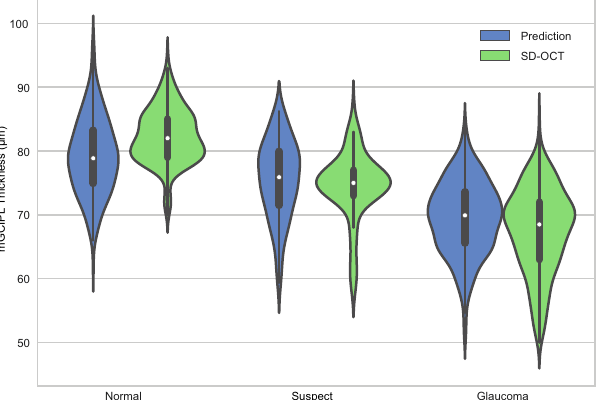
Figure 3. Violin plots demonstrating distribution of HDLM predictions and SD-OCT-measured average mGCIPL thicknesses in normal, suspect, and glaucomatous eyes. (HDLM = hybrid deep learning model; mGCIPL = macular ganglion cell-inner plexiform layer; SD-OCT = spectral domain-optical coherence tomography).